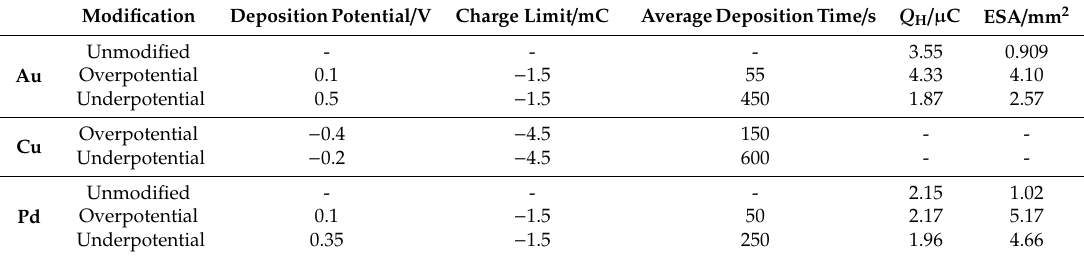
Table 1. Deposition parameters: deposition potential, charge limit fixed for deposition, average deposition time (from three repeat deposits), charge ( Q H ), and electroactive surface area (ESA). Q H and ESA were calculated from the integration of the Au 2 O 3 or PdO reduction peak obtained in 0.5 M H 2 SO 4 at 500 mVs − 1 vs. Ag /